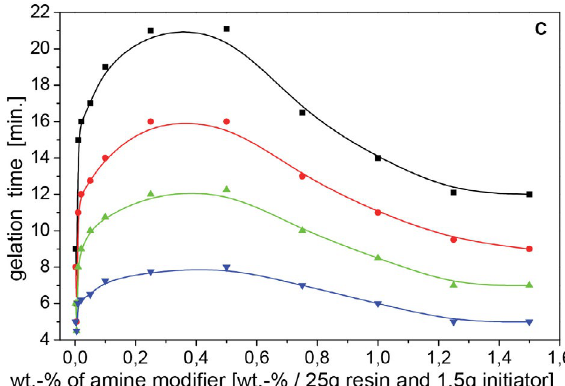
Figure 3. Gelation times of unsaturated polyesters resins with vari- ous amount of chemically incorporated modifier A and cobalt ac- celerator. To 25 g of resin, 0.5 g (plot A), 1.0 g (plot B), and 1.5 g (plot C) of butanone peroxide initiator was added; the amounts of cobalt accelerator: ( ■ ), 0.10 mL; ( • ), 0.15 mL; ( ▲ ), 0.25 mL; ( ▼ ), 0.50